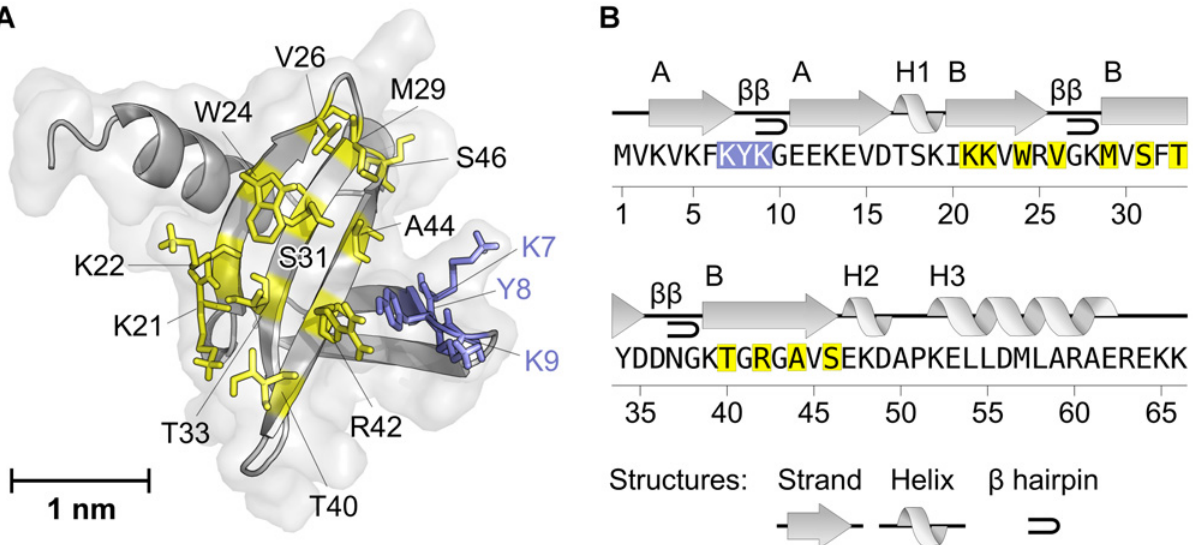
Fig 1. Structure of the Nanofitin OB-fold scaffold and randomized libraries. (A) Cartoon representation of wild-type Sac7d (Protein Data Bank code 1AZP). (B) Secondary structure plot of wild-type Sac7d. Helices are labeled H1, H2 and H3 and strands by their sheets A and B, from N-terminal to C- terminal extremities. Beta-turn motifs are indicated with β . Residues randomized in the library involved in the generation of anti-GFP Nanofitins are shown in (A) yellow sticks and (B) yellow frames. Residues of the first loop randomized in early library are shown in (A) purple sticks and (B) purple frames.